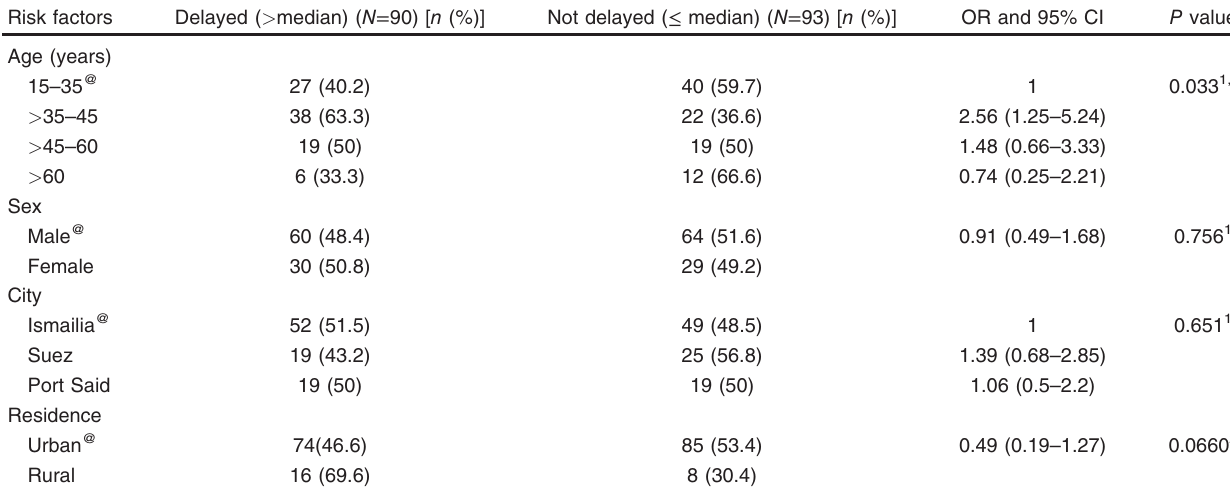
Table 8 Risk factors for total delay among studied patients (age, sex, city, and residence) ( N = 183) Risk factors